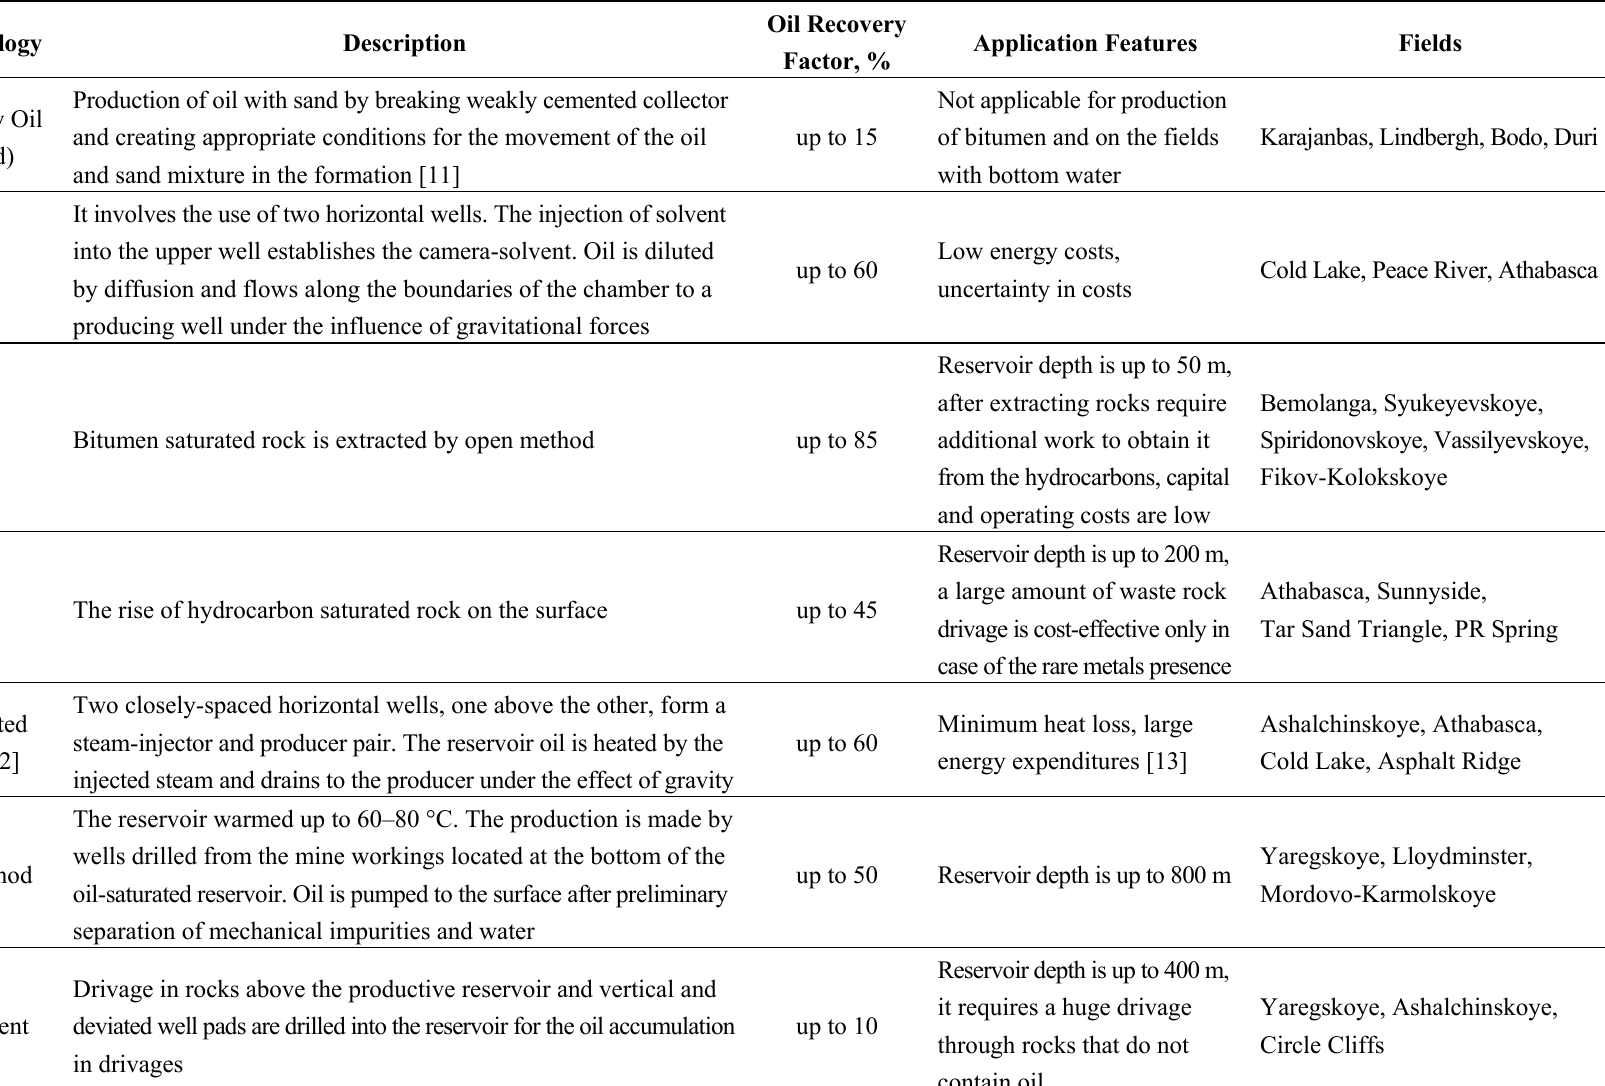
Table 1. Unconventional oil recovery